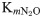
Comparison of the measured N2O with that simulated.Each main panel (A–D) compares the measured N2O (single vial results) with the default simulation using the parameter values given in Table 2, i.e., KmN2O = 0.6 μM (estimated through optimisation) and vemaxN2O− = 5.5×10−15 mol e- cell-1 h-1 [24]. In contrast, each inserted panel shows the simulated N2O assuming 1) N2O consumption only by the cells producing N2O (ZNaNi + ZNi), and 2) the literature value for KmN2O = 5 μM [42]. The results show that the default simulation best explains the measured N2O kinetics, assuming its production by a small fraction (ZNaNi + ZNi) and consumption by the entire population (Z− + ZNa+ ZNaNi + ZNi).